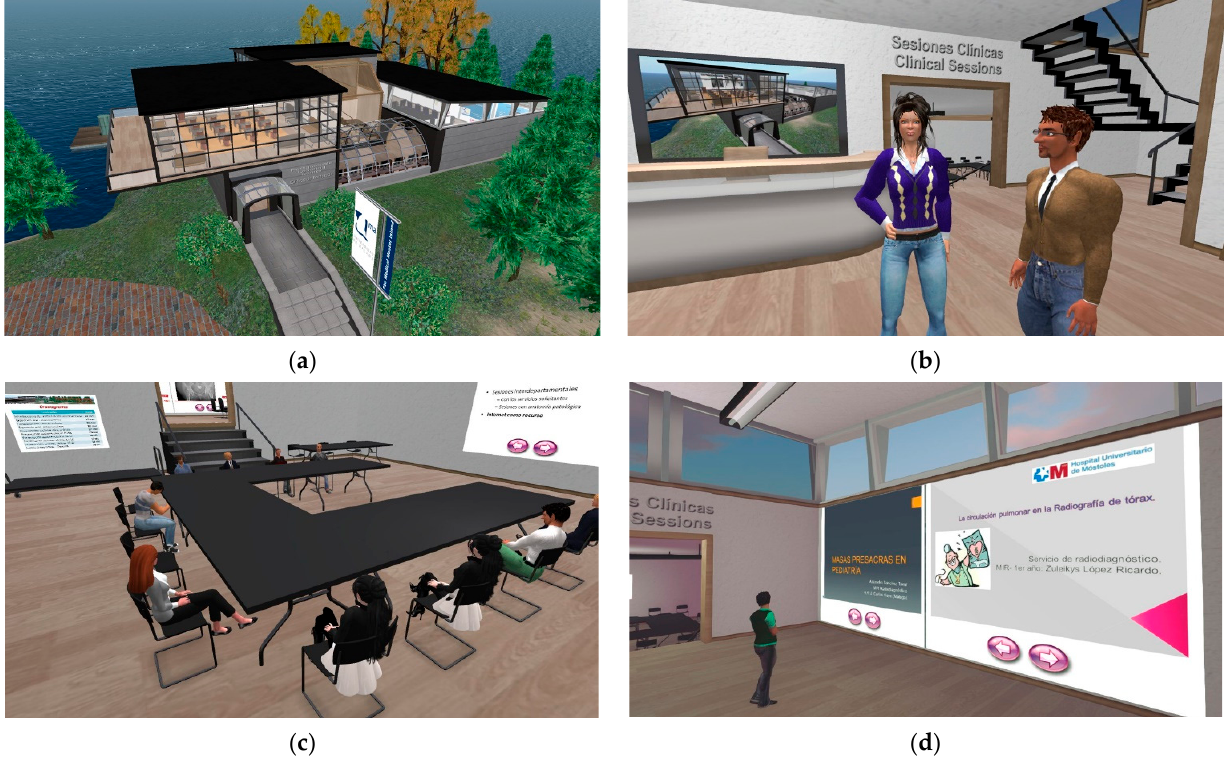
Figure 2. Various images of virtual settings where the present study was carried out: ( a ) exterior view of the Postgraduate Building, ( b ) entrance hall, ( c ) clinical session room with attendees seated around the U-shaped table, and ( d ) exhibition room with the presentations shown on screens